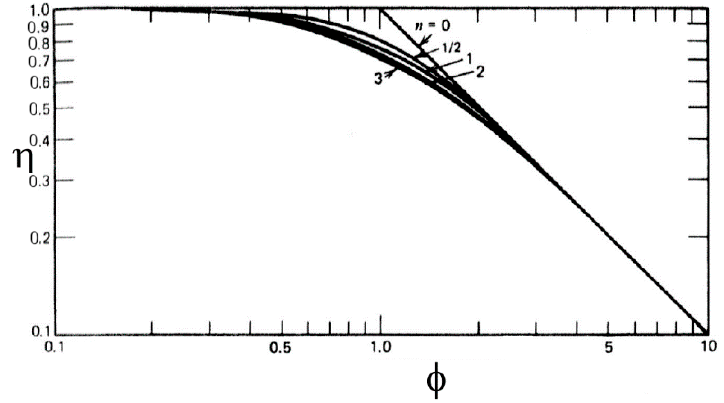
Figure 6. E ff ectiveness factor versus Thiele modulus for di ff erent order of reaction. Re-elaborated from Figure 6. Effectiveness factor versus Thiele modulus for different order of reaction. Re-elaborated Froment and Bischo ff from Froment and Bischoff [21].